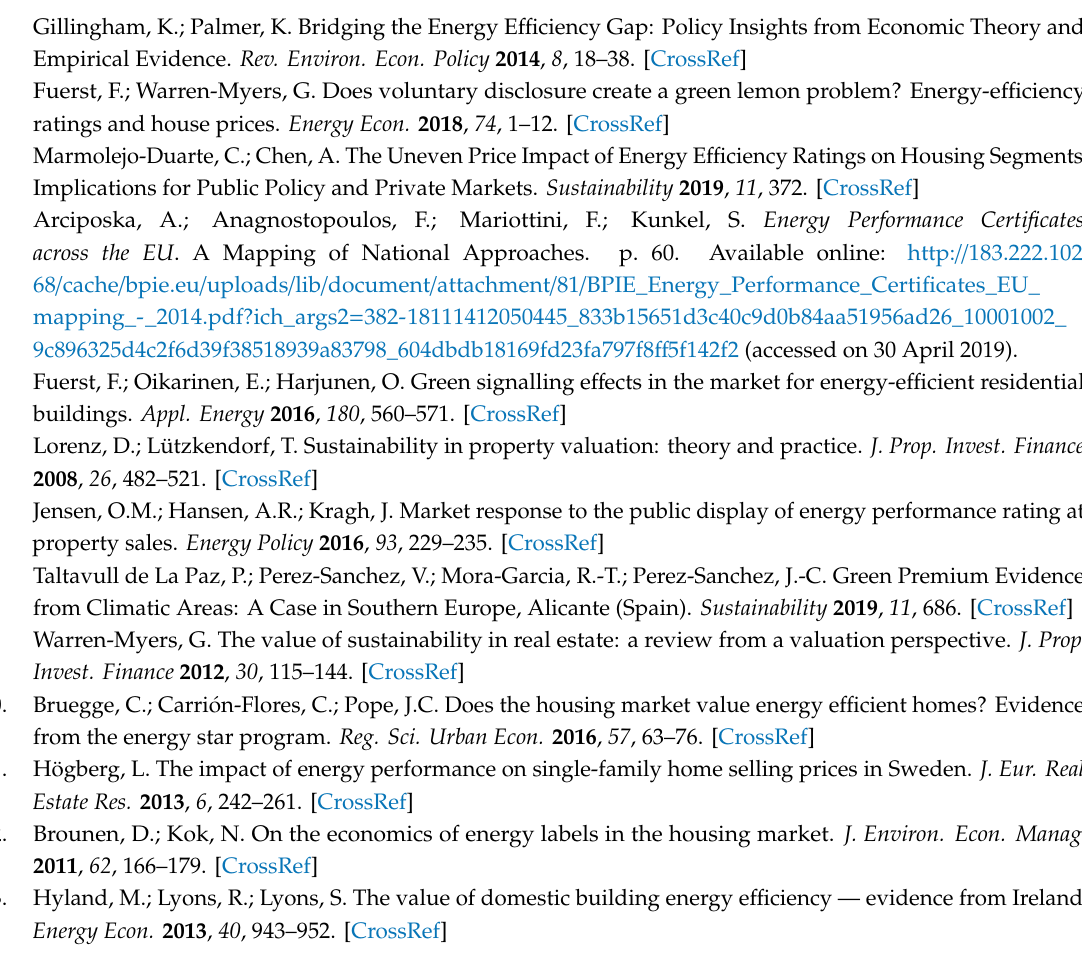
Table S1: Multivariate response